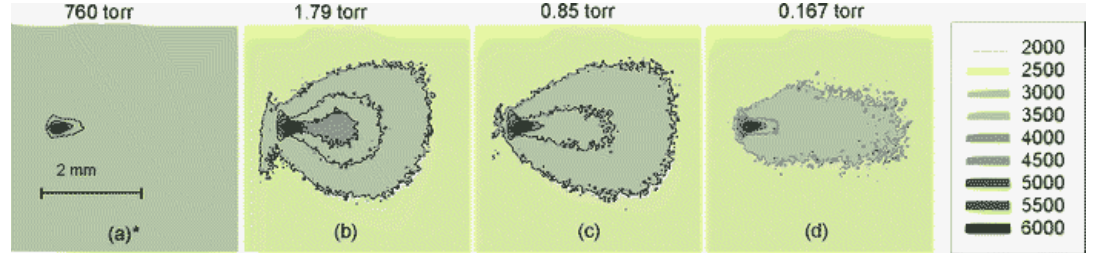
Figure 5. Two-dimensional Cu plasma images at different pressures produced using an accumulation of ten 50  J laser pulses, 10 ns second delay and 500 ns gate width. Reprinted from reference